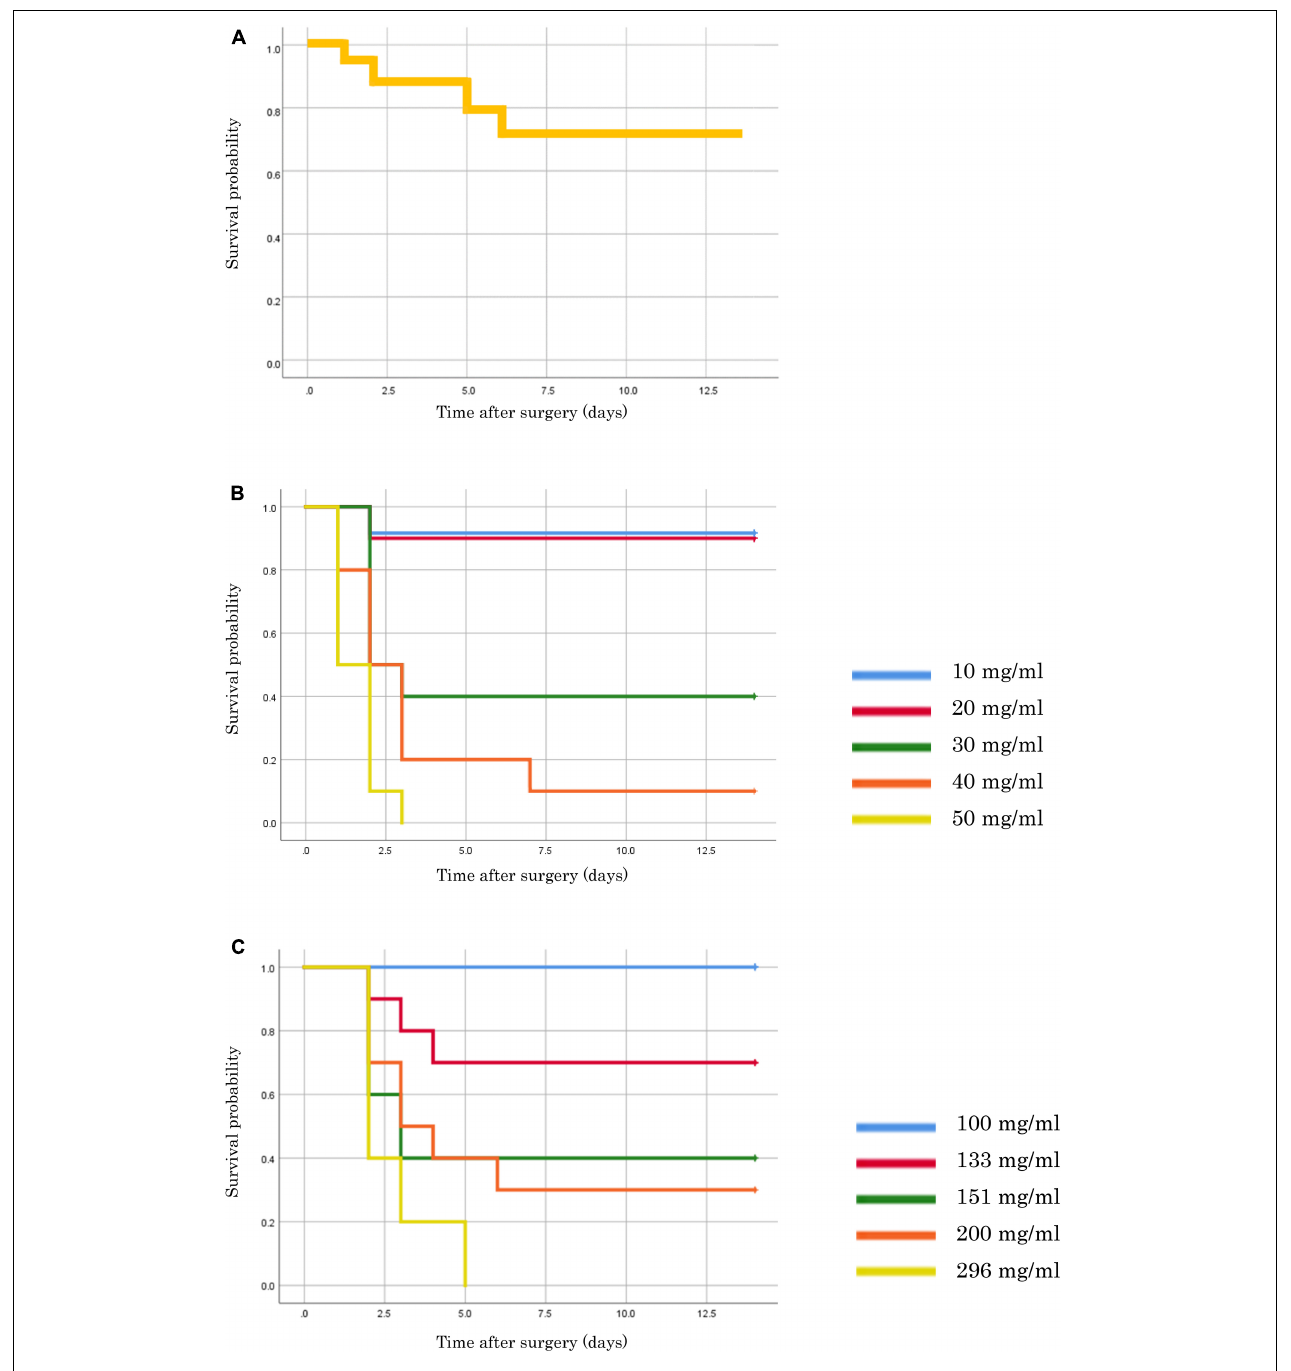
FIGURE 2 | Survival rates of each model mouse. (A) CLP model. (B) FSI model of thin fecal suspension (without antimicrobial administration). (C) FSI model of thick fecal suspension (with antimicrobial administration). fine filtration using a Falcon 70 µ m Cell Strainer (product number 352350; Corning, New York, United States). Thin